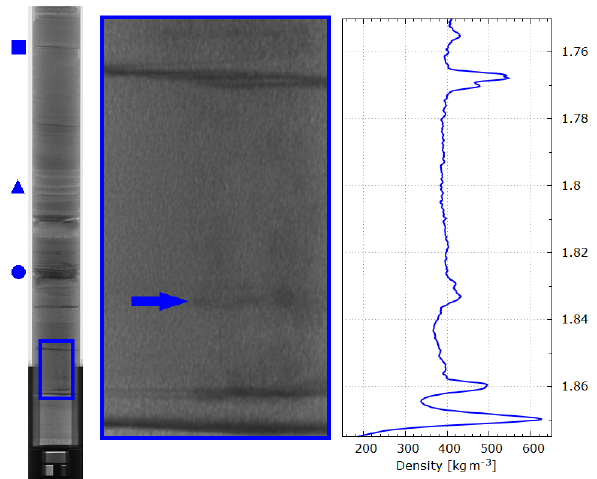
Figure 2. Example 2-D CT image of a 1m liner (1–2m depth) and a zoomed section showing two melt layers aligned with the respective densities. In the left image a distinct density layering (e.g., blue triangle), several melt layers (e.g., blue circle) and wind crusts (e.g., blue square) are visible. Above the lower zoomed melt layer a clear percolation pattern (blue arrow) can be seen on the right-hand side of the snow